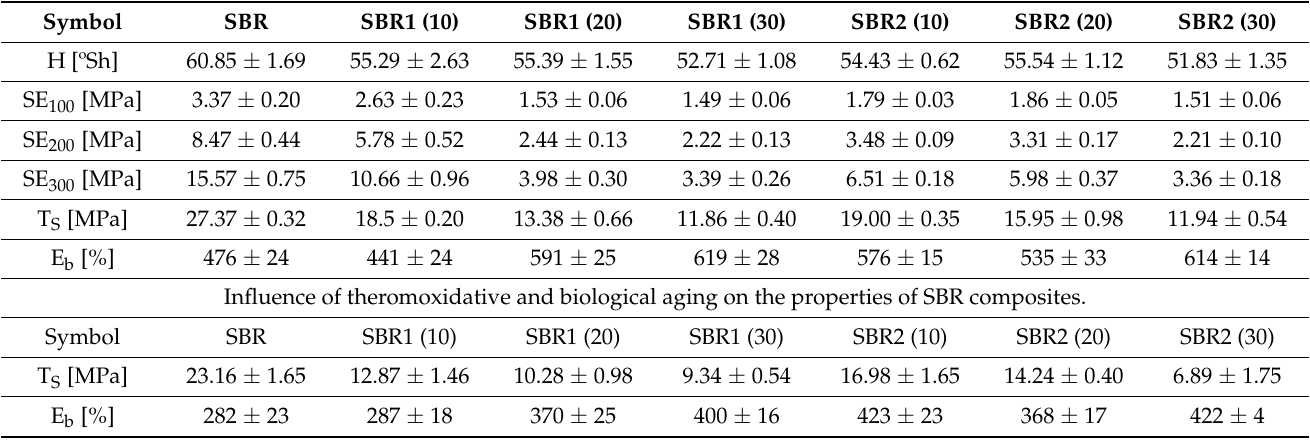
Table 5. Influence of BCA filler on the mechanical properties of the SBR